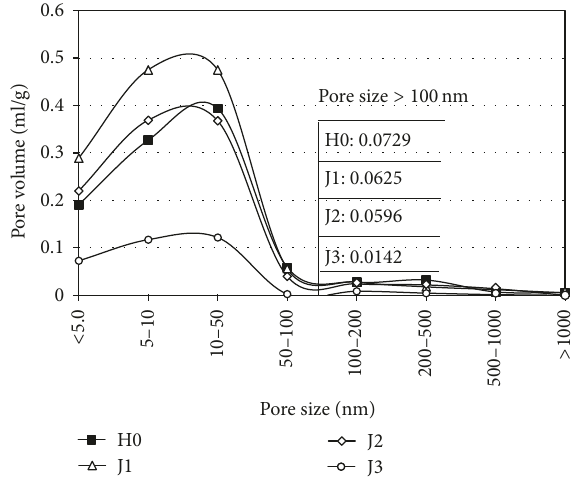
Figure 8: Pore size distribution in the samples.